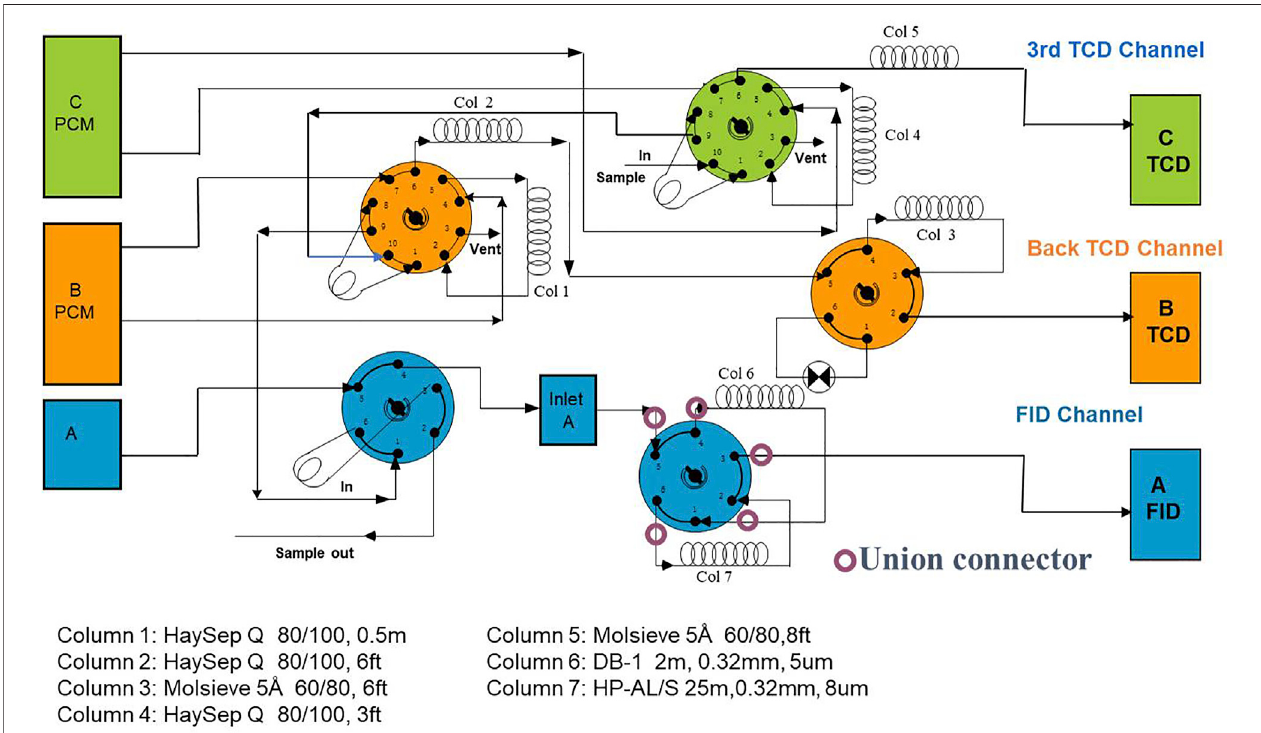
FIGURE 2 | Con fi guration of Agilent 7890B gas chromatograph (GC) with 5 valves, 7 columns and 3 detectors for analyzing hydrocarbon and non-hydrocarbon components of natural gas.